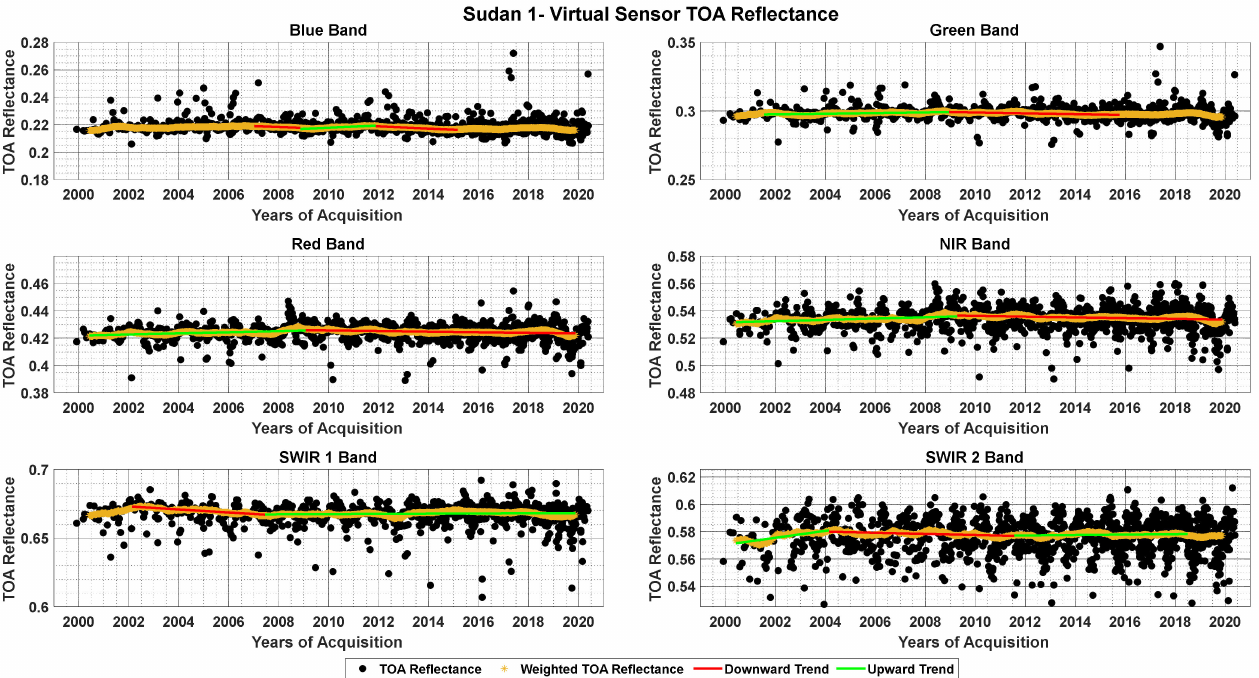
Figure 7. TOA reflectance data of virtual constellation over Sudan 1 for blue, green, red, NIR, SWIR 1, and SWIR 2 bands with fitted trend line before and after turning